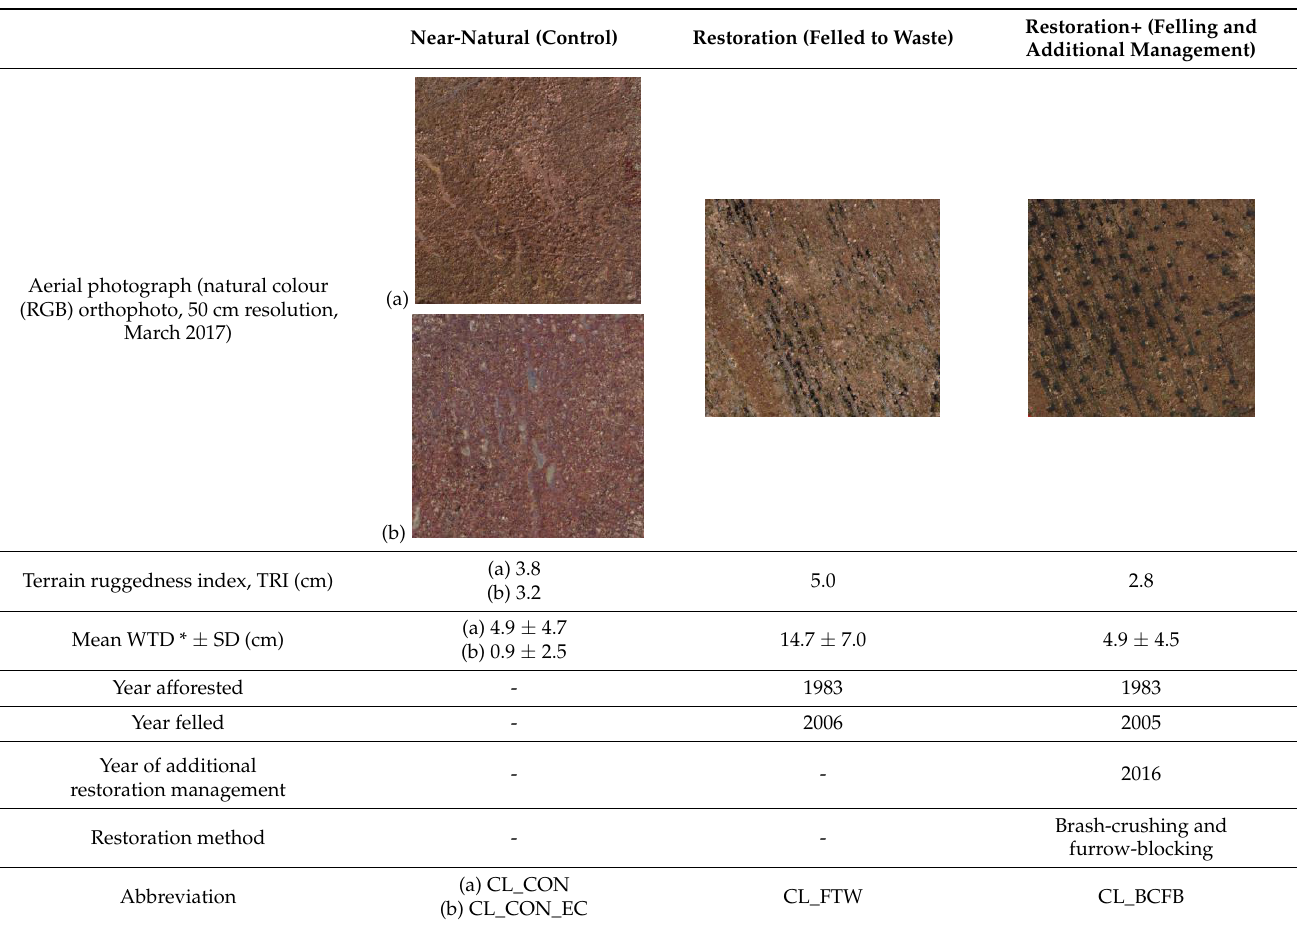
Table 3. Forsinard Flows Cross Lochs sites’ characteristics. Two near-natural Cross Lochs sites were used in this study and are described as (a) CL_CON and (b) CL_CON_EC (location of the long-term